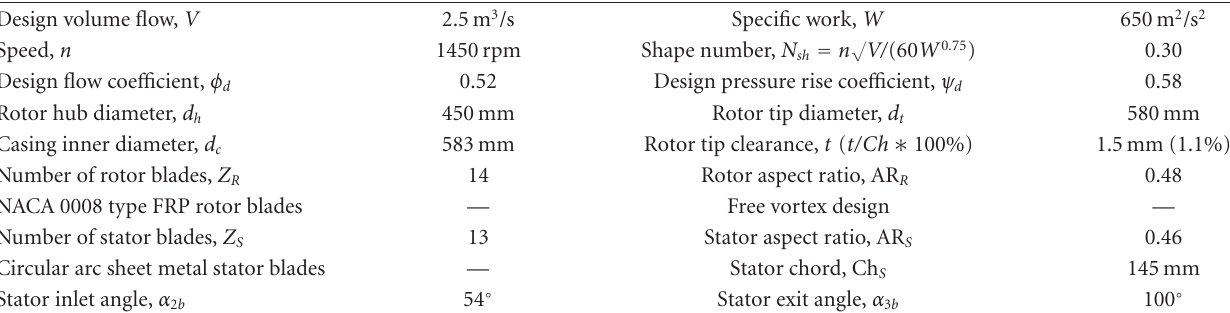
Table 1: Details of the low-aspect-ratio axial-flow fan.